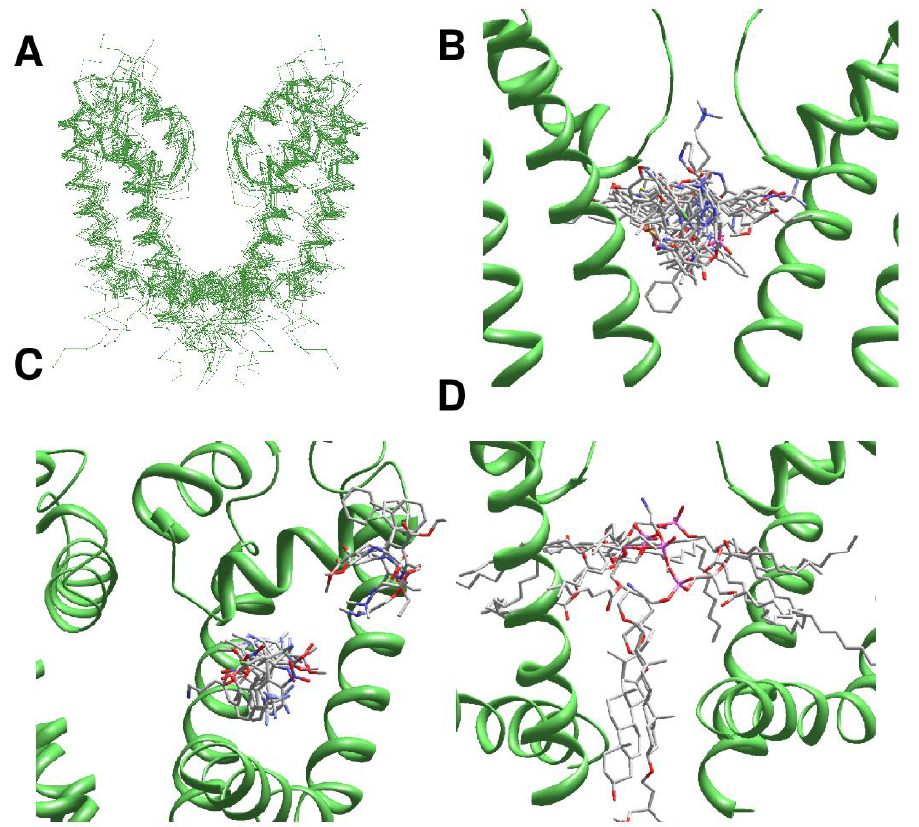
Figure 2. Ligands in the pore domain of P-loop channels. Carbon, oxygen and nitrogen atoms of ligands are gray, red and blue, respectively. ( A ), C α tracing of the pore domain in 25 drug-bound P-loop channels. For clarity, only two subunits/repeats without drugs are shown. The structures are 3D-aligned as described in Methods. ( B ), Superimposition of ligand-channel complexes with ligands in the inner pore. Only two subunits of the KcsA channels are shown for clarity. Ligand molecules fill the entire central cavity. ( C ), Superimposition of channel complexes with ligands bound in subunit/repeat interfaces (between P1 helix and two inner helices). Most ligands are close to the pore. Exceptions are DHP drugs in CavAb, which are far from the pore axis. ( D ), Lipid and detergent molecules bind in the inner-pore central cavity, fenestrations, or in the activation gate region.